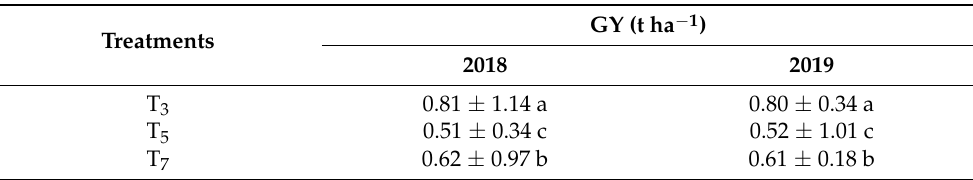
Table 3. Grain yield (GY) of black gram sown as sole crops and in intercropping systems with maize under semi-arid conditions.